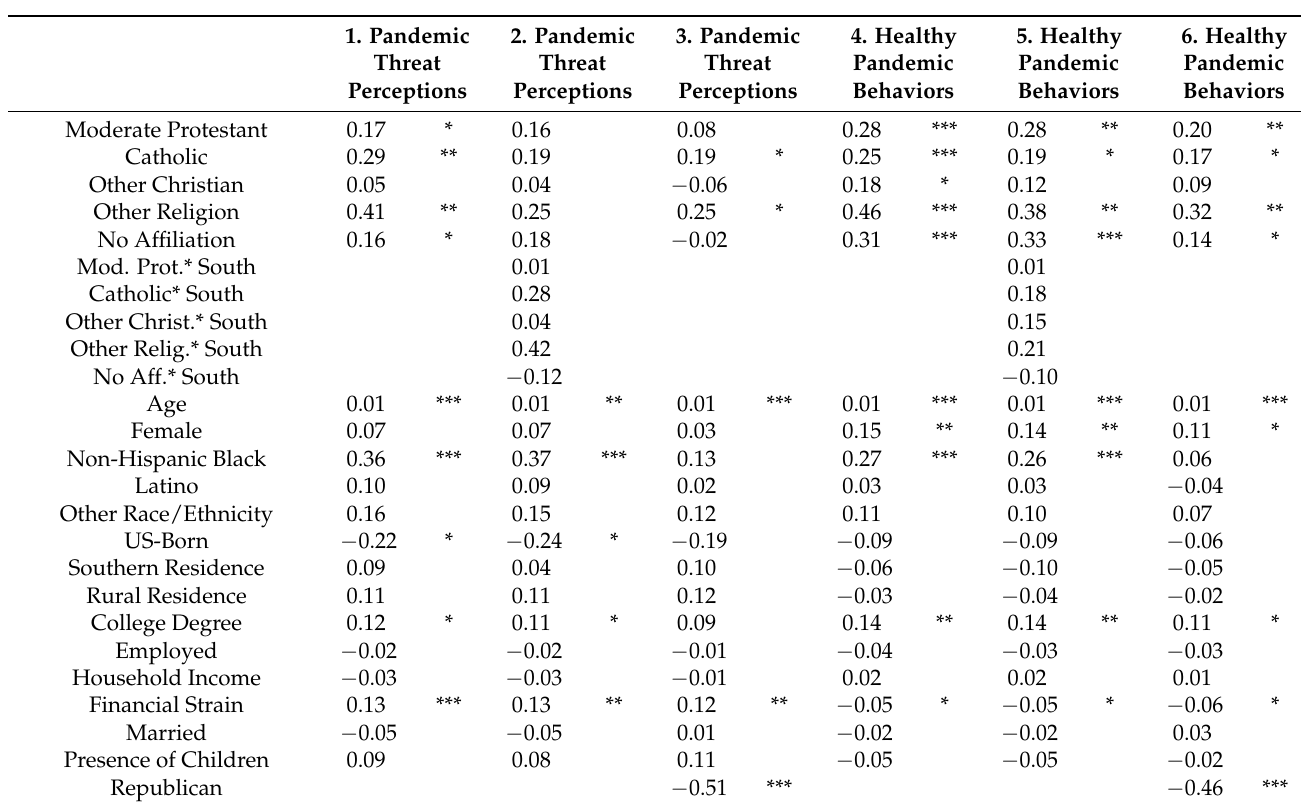
Table 2. Weighted regressions of pandemic threat perceptions and healthy pandemic behaviors (CHAPS 2021).